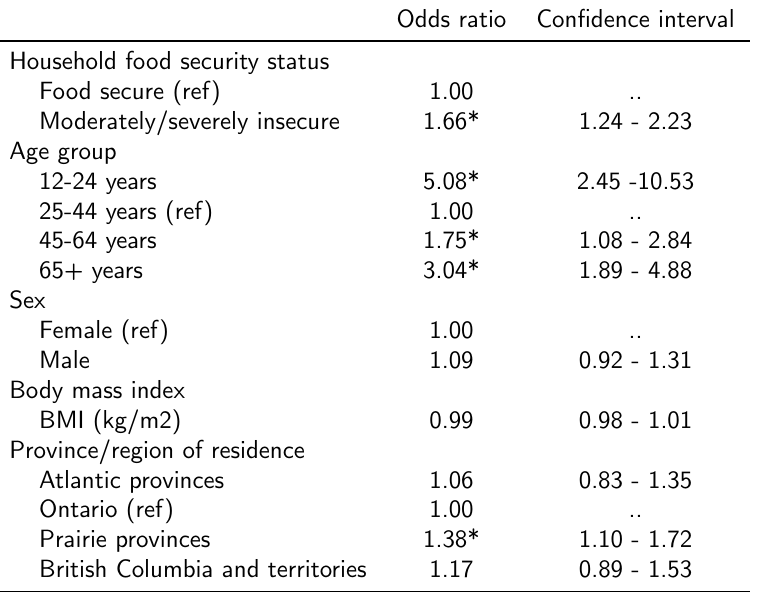
Table 2: Adjusted odds ratios (and 95% confidence intervals) for the risk of hospitalization for diabetes or a comorbid condition among community-dwelling persons living with